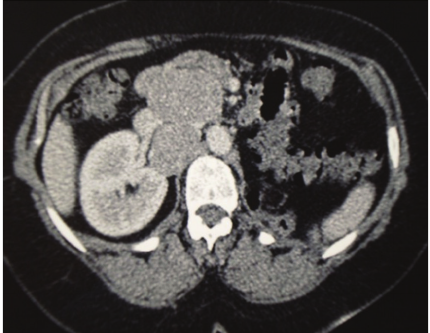
Figure 3: Contrast enhanced abdominal CT scan shows an empty renal lodge on the left side with voluminous retroperitoneal lym- phadenopathies pre- and retroinferior cava rolling the inferior vena cava and the right renal